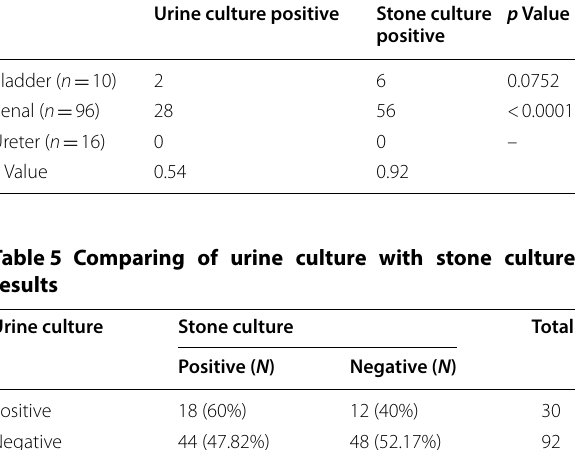
1.342 with 1 degree of freedom; p =